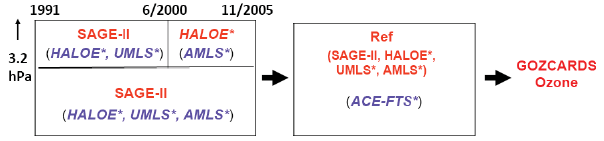
Figure 18. Schematic diagram describing the creation of the merged GOZCARDS monthly zonal mean ozone data record from various satellite data sets. Instruments represented in red inside the boxes are used as a reference. Instruments whose measurements have al- ready been adjusted to a reference are indicated with a “*” super- script. AMLS refers to Aura MLS, and UMLS to UARS MLS. See text for more details.